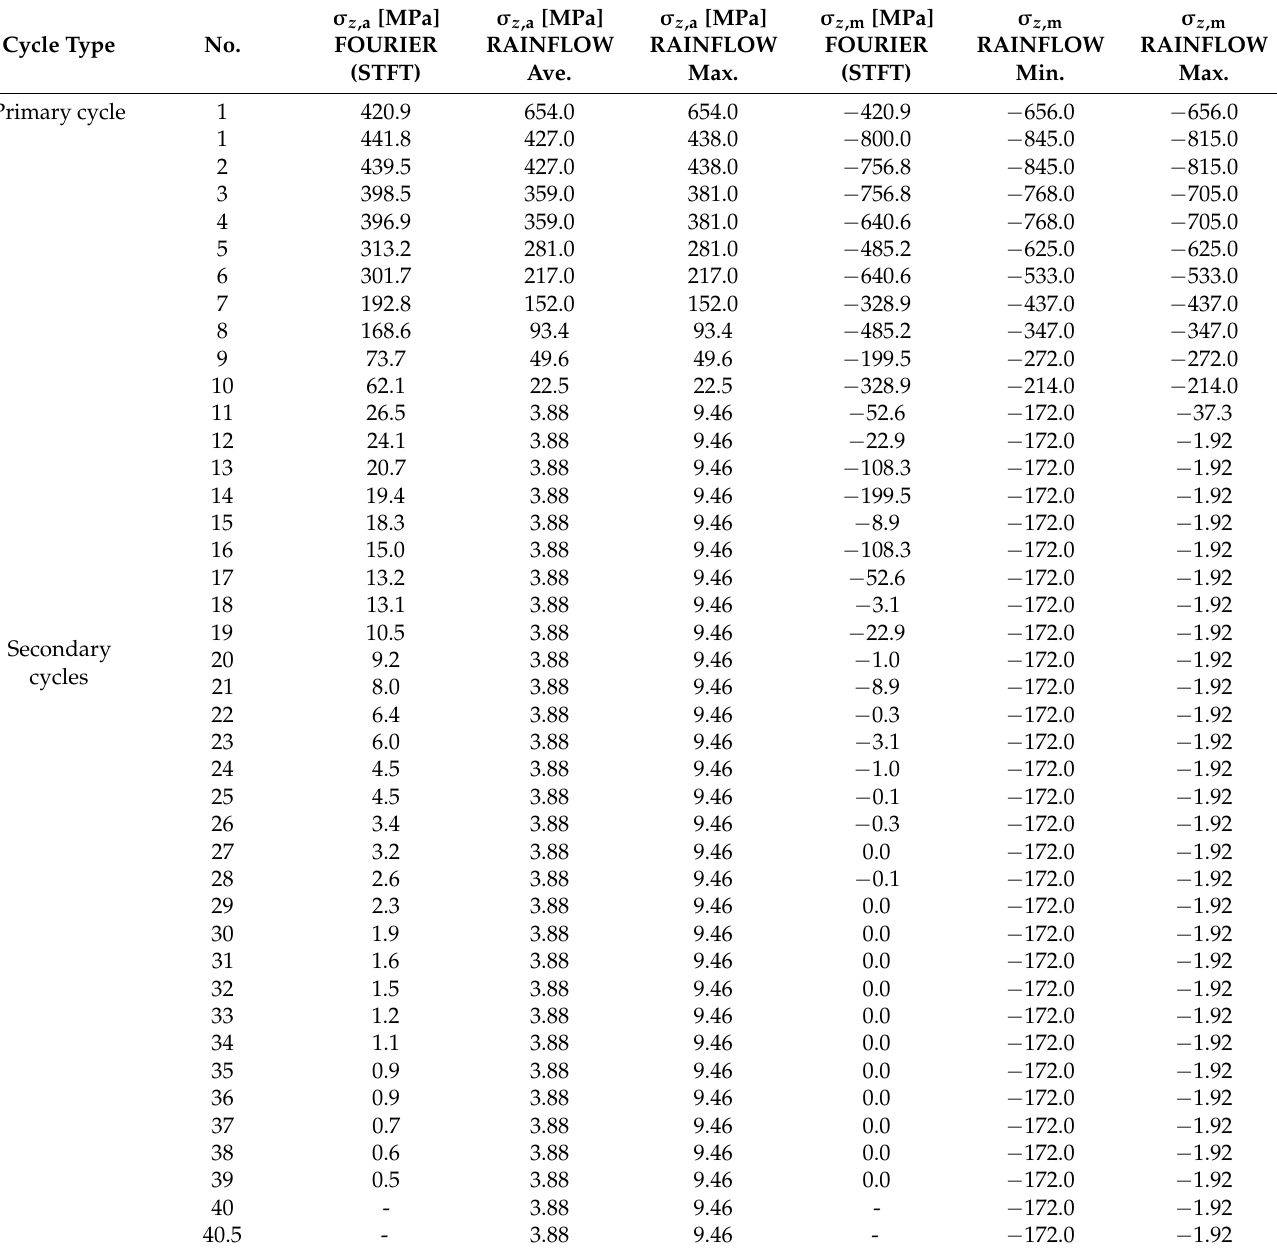
Table 4. Identified mean values and amplitudes of σ z stress